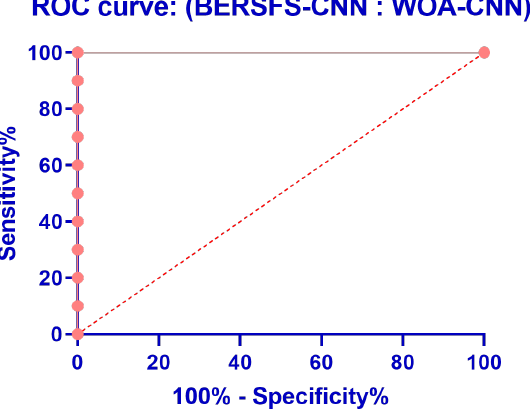
Figure 7. ROC curve of the proposed BERSFS-CNN algorithm versus the BER-CNN algorithm.